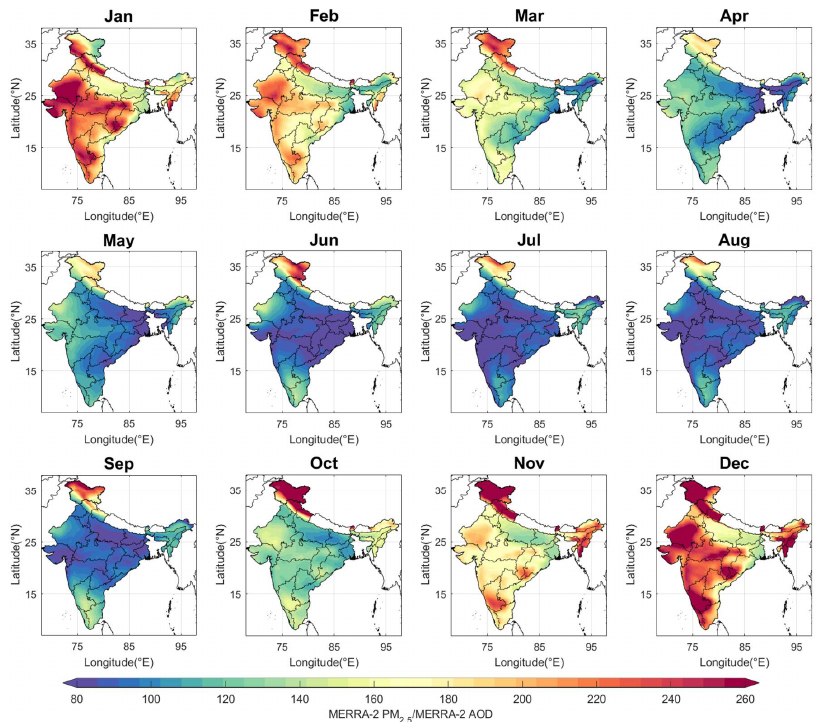
Figure A4. Spatial patterns of mean monthly η over India as derived from MERRA-2 data. η values are derived for each day during the entire study period and used to estimate PM 2.5 from satellite AOD.